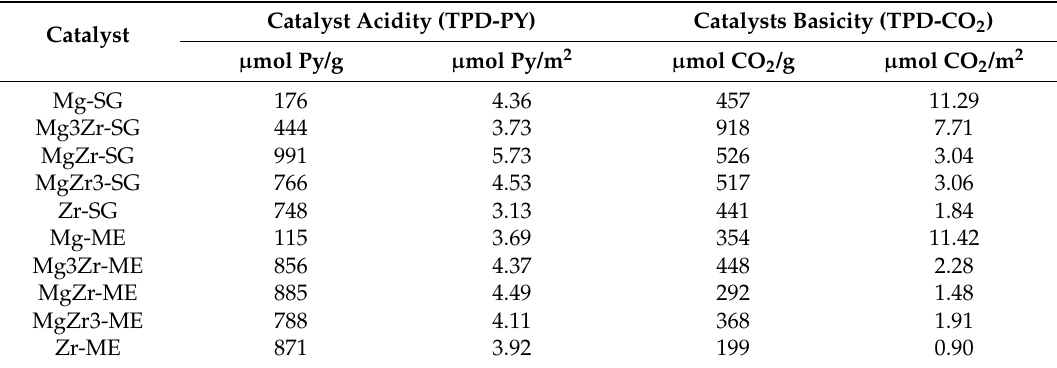
Table 2. Catalysts Surface acid-base properties obtained from temperature programmed desorption